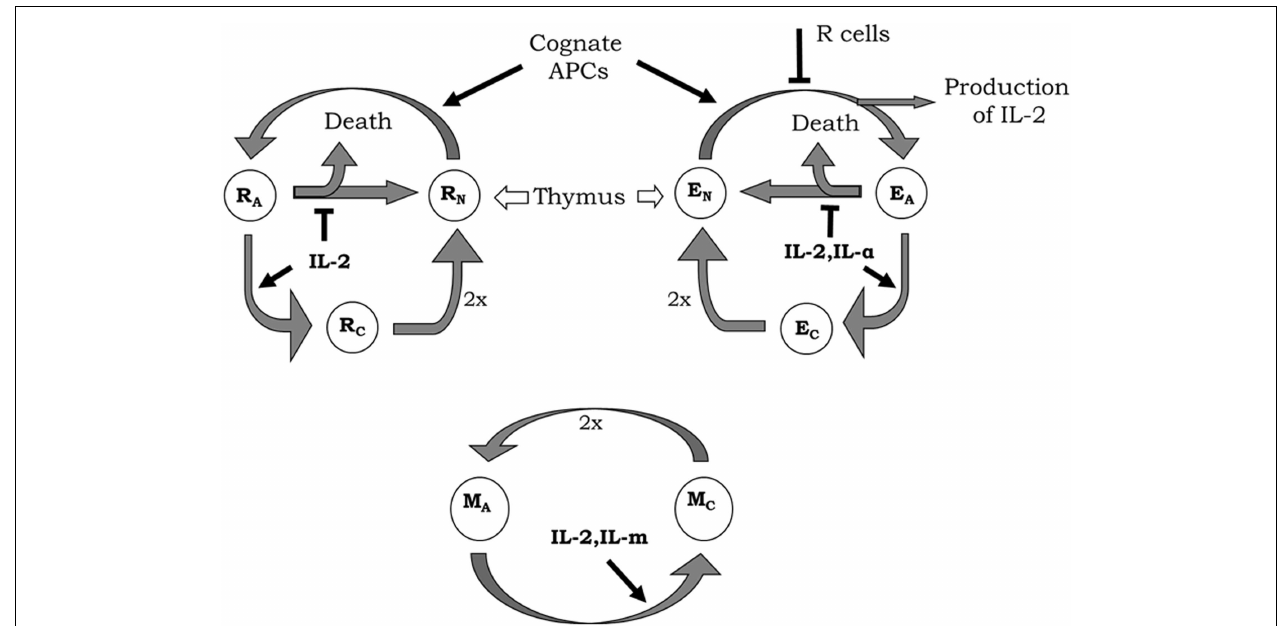
become inactivated, where a fraction of cells simply returns back to the resting state and the other dies. Cycling E (E C ) and R (R C ) cells divide with a constant rate generating two new resting E or R cells, respectively. MemoryT cells are assumed as being always in a sort of naturally activated state (even without any strong cognate interaction with APCs). Activated M (M A ) cells enter the cell cycle when receiving enough signals from IL2 or another external cytokine (IL-m). Cycling M cells (M C ) divide generating two new activated M